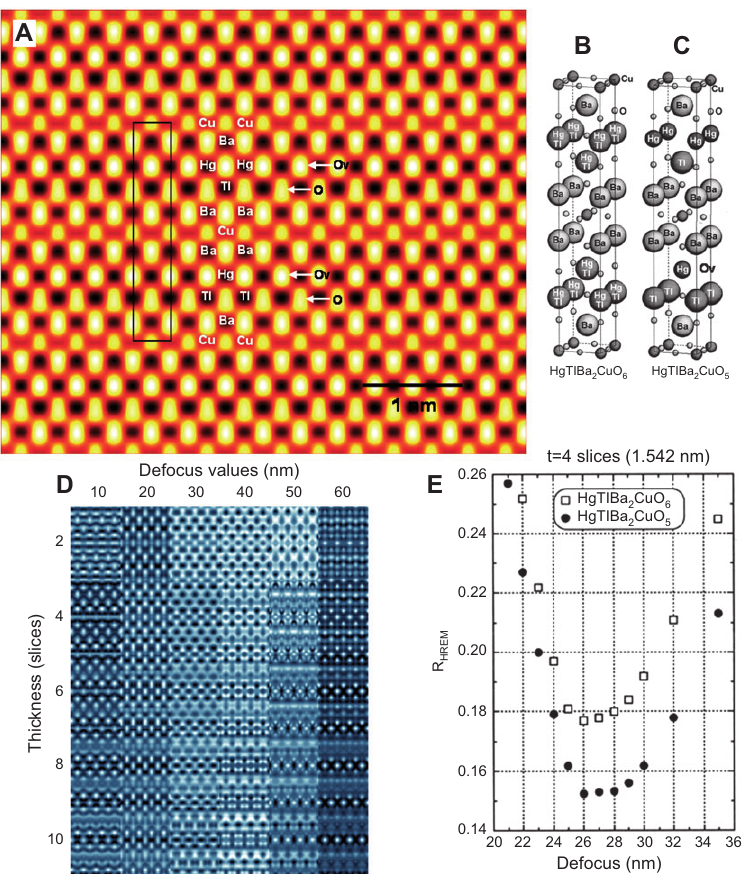
CuO taken along the [100] direction. Black lines indicate unit cell. Structure models of (B) 2 x CuO . (D) Calculated HREM images of HgTlBa 2 5